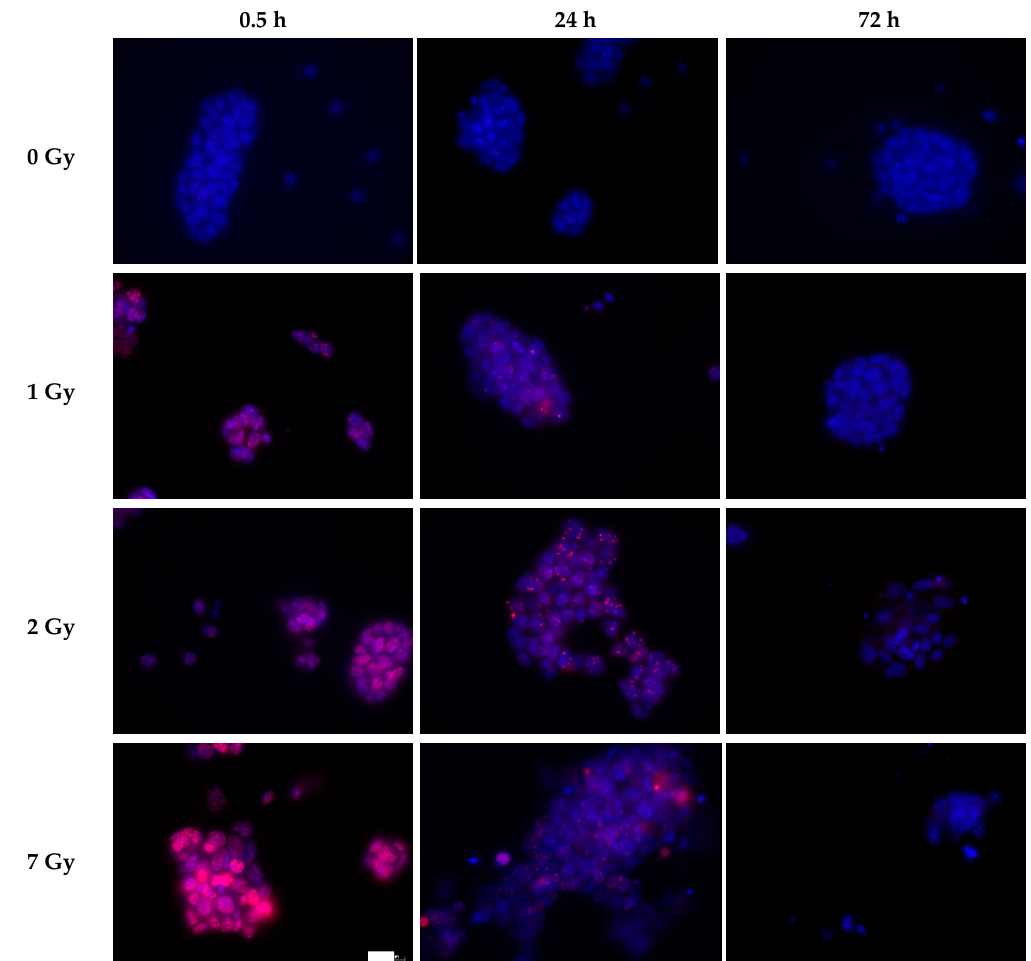
Figure 7. Representative images of γ H2AX foci in mESCs after exposure to X-rays in the absence of LIF. Cells were seeded on cover slips, grown for one day and exposed to X-rays. Cells were fixed with 3.5% formaldehyde at the indicated time points. Immunofluorescence staining was performed using a γ H2AX antibody (pink foci), and cell nuclei were stained with DAPI (blue). Scale bar (white box) 20 μ m.